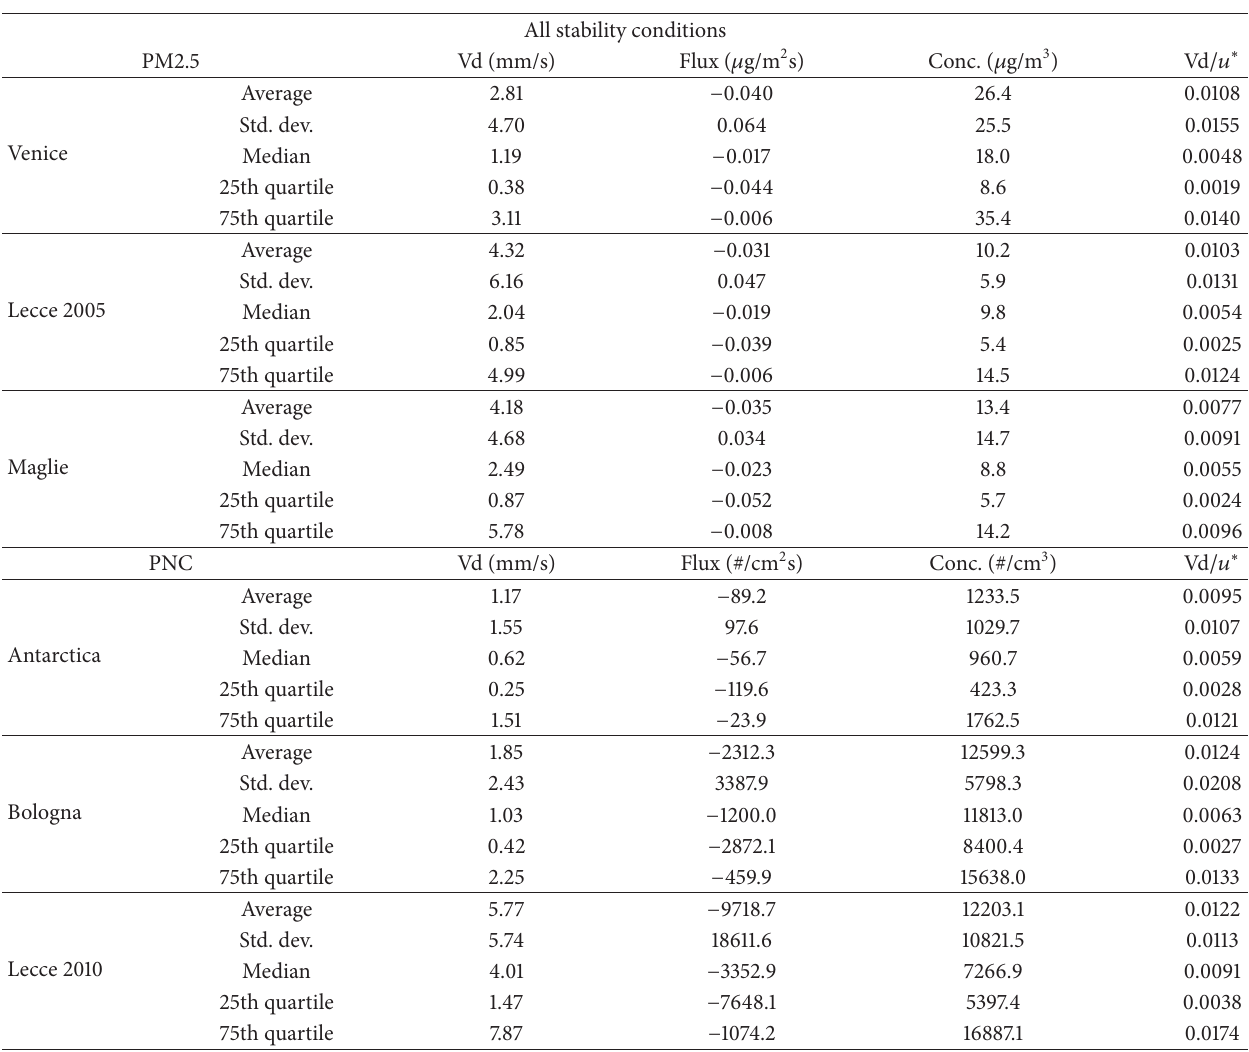
Table 3: Average (with standard deviation) and median (with 25th and 75th quartiles) values are reported for deposition velocities, fluxes, concentrations, and normalized deposition velocities for each site, separating PM2.5 from particle number data. In this table all data is considered, without any selection involving stability